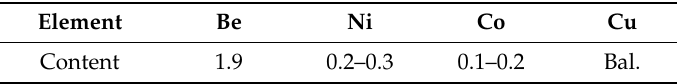
Table 1. The composition of Cu-Be-Ni-Co alloy (wt %).